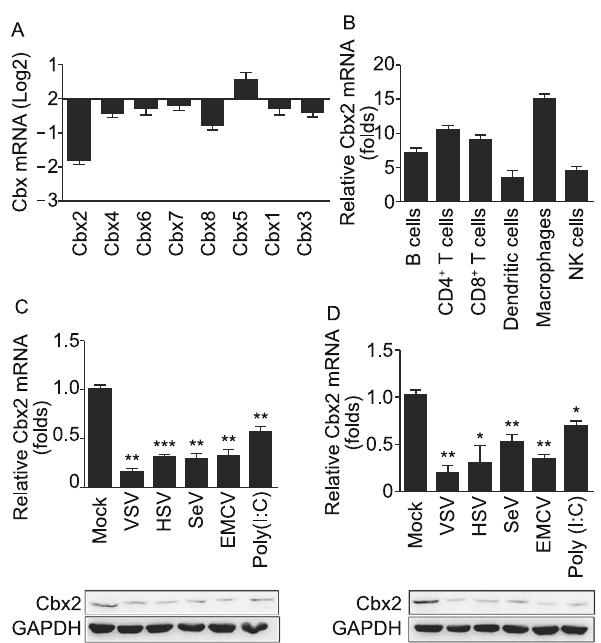
Figure 1. Virus infection down-regulates Cbx2 expression in macrophages. (A) Q-PCR analysis of CBX family proteins in mouse peritoneal macrophages infected with VSV (MOI = 10) for 8 h. The fold change was calculated relative to the expression in uninfected cells. (B) Q-PCR analysis of Cbx2 in different immune cells. NK, natural killer cells. Expression was normalized to the expression of β -actin. (C and D) Q-PCR analysis and Western blot of Cbx2 in mouse peritoneal macrophages (C) or RAW264.7 cells (D) infected with virus (MOI = 10) or incubated with Poly (I:C) (100 μ g/mL) for 8 h. All data are from three independent experiments (mean ± SEM of technical triplicates) (C and D). Data are representative of three independent experiments with similar results. * P < 0.05; * P < 0.01; *** P